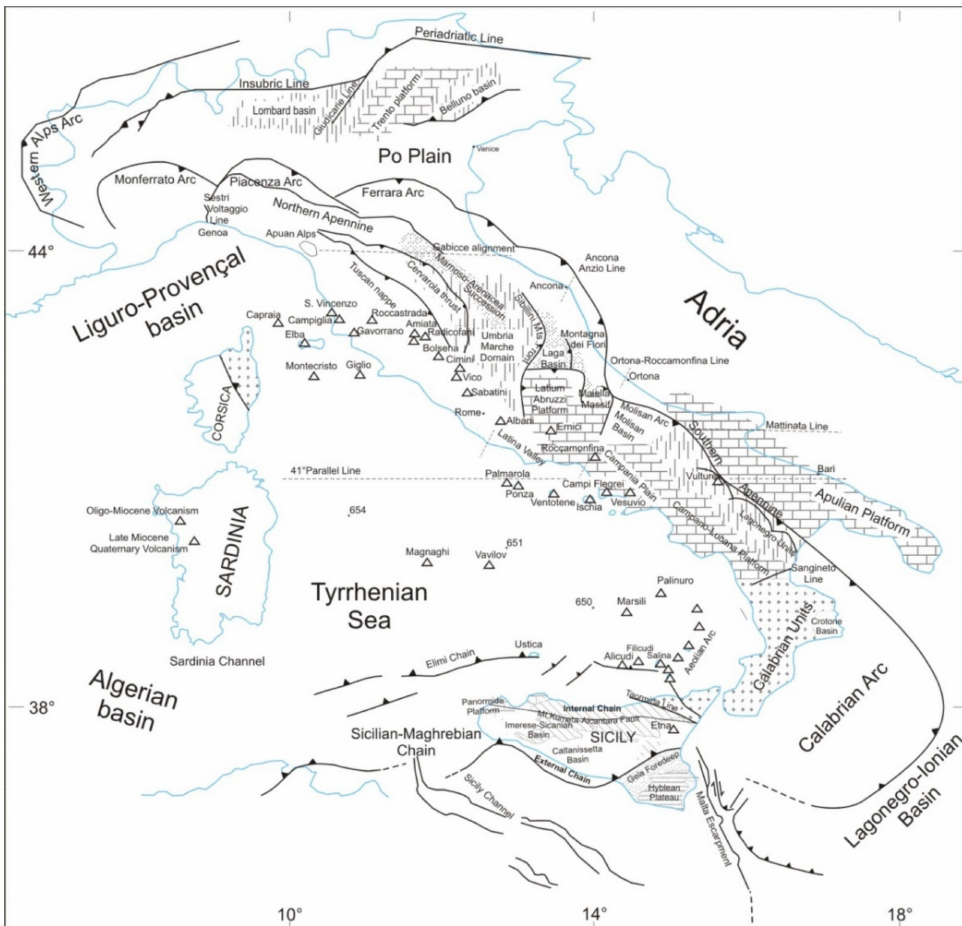
Figure 4. Location map of the main paleogeographic and structural units, modified after